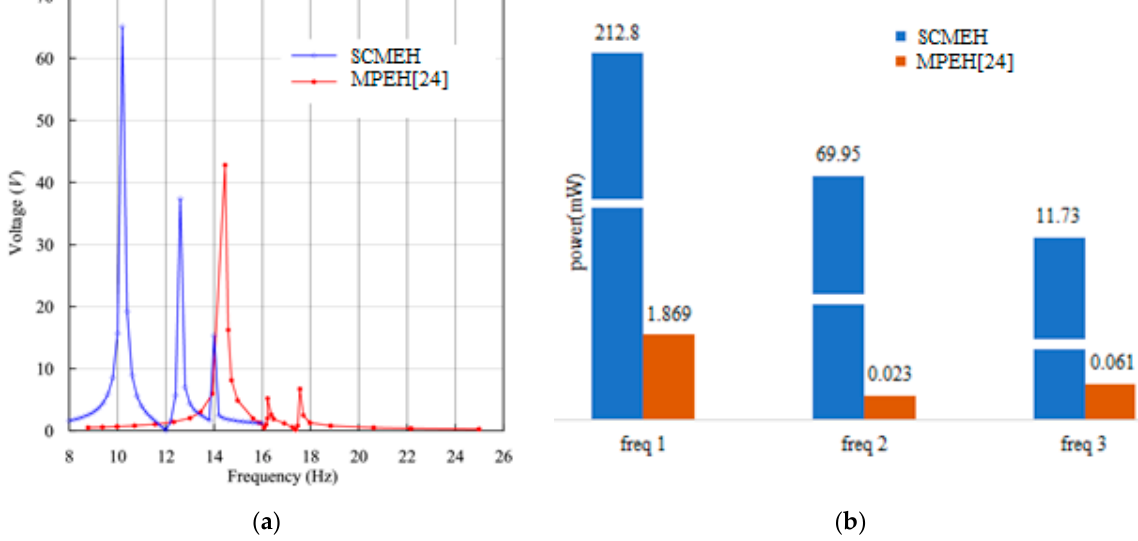
Figure 10. Comparison of SCMEH and MPEH multimode energy harvesters [24]: ( a ) voltage comparison and ( b ) power comparison. Table 3. Power values of SCMEH and